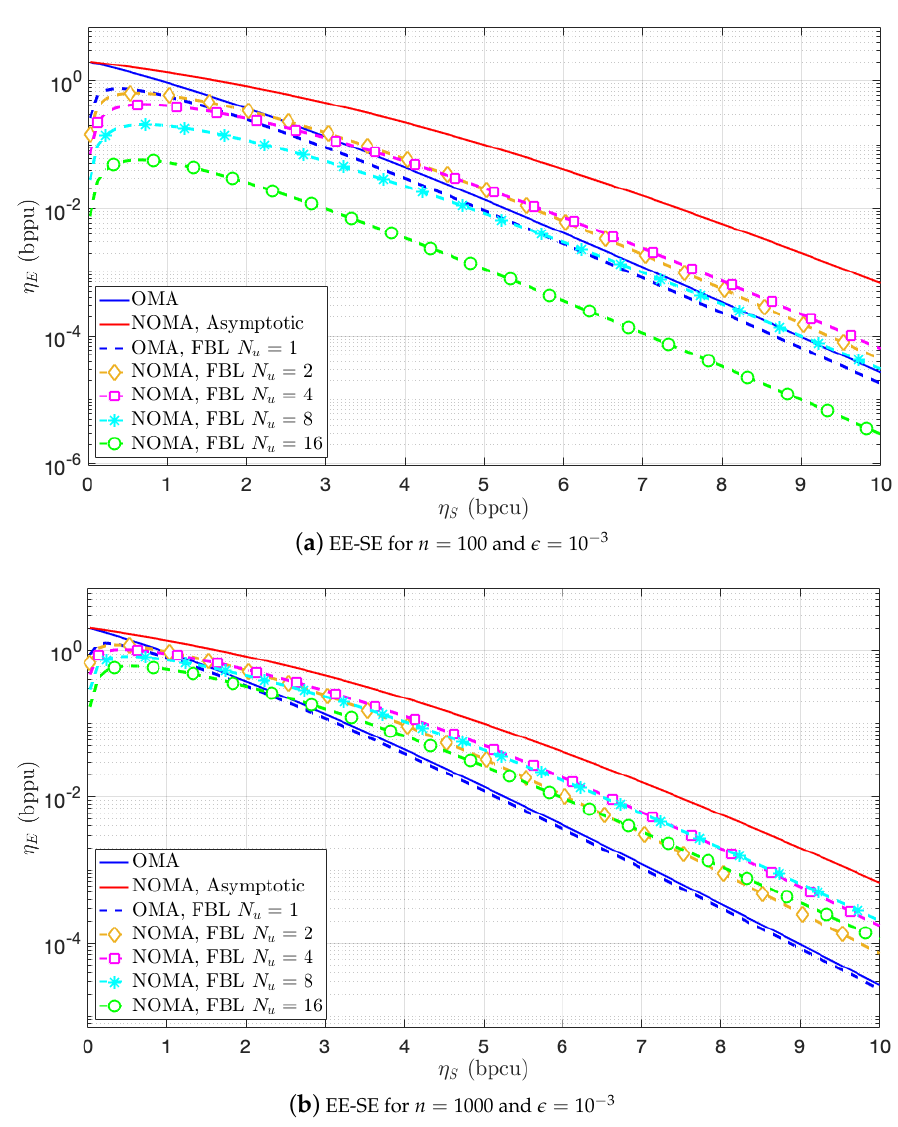
Figure 7. EE-SE trade-off for different number of channel uses n and for a per-user probability of error (cid:101) = 10 − 3